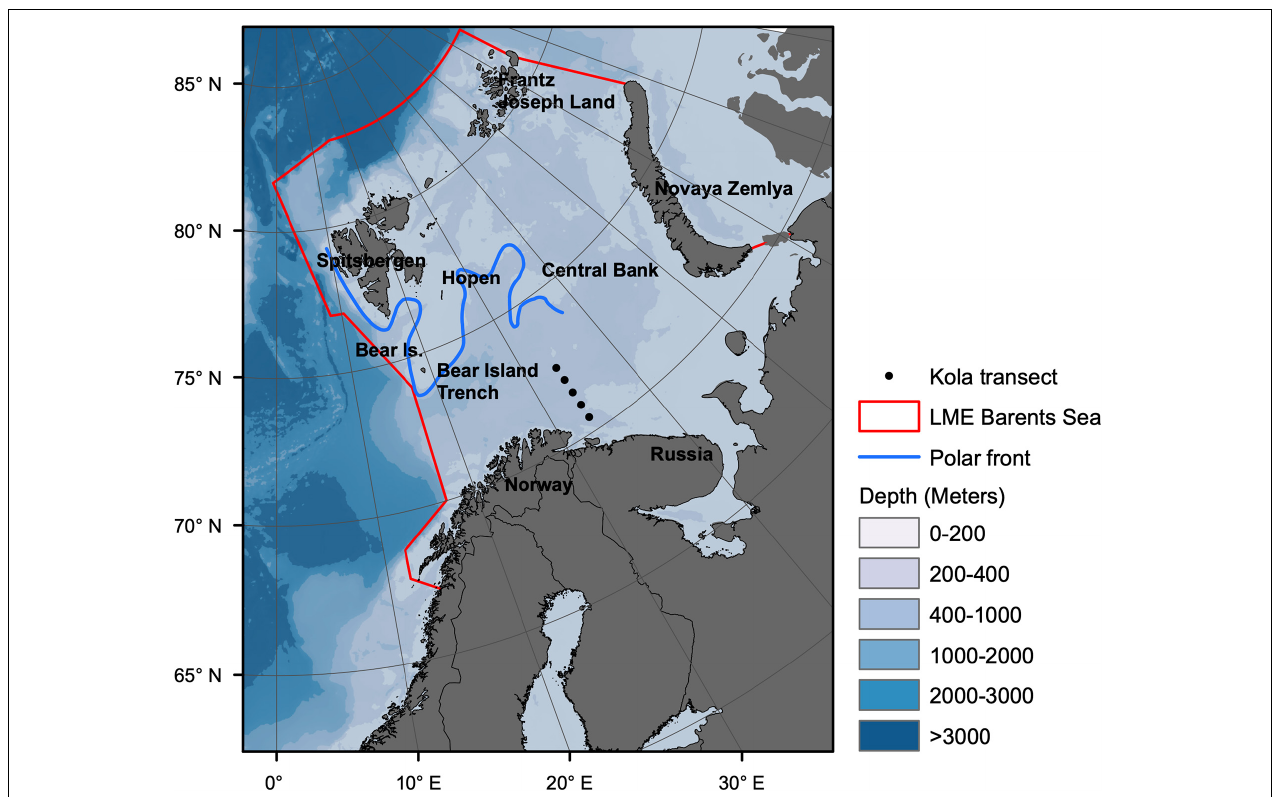
FIGURE 1 | Map of Barents Sea large marine ecosystem. Borders of the ecosystem are shown by red lines Based on (https://www.pame.is/projects/ecosystem-approach/arctic-large-marine-ecosystems-lme-s). The Kola transect stations 3–7 for hydrographic monitoring are shown as black dots. Location of the polar front is shown by blue